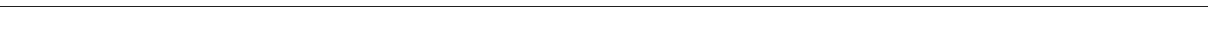
Fig. 6 The PHD module of BAZ1A binds free and nucleosomal DNA. a Sequence alignment of the PHD modules of BAZ1A, BAZ1B, and the most N-terminal PHD module of dAcf1 amino acid boundaries are indicated, and identical residues are highlighted in gray . Filled and open circles indicate the Zn-binding Cys 4 HisCys 3 motif characteristic of the PHD fold. Green arrowheads indicate K1181 and K1183 that are required for BAZ1A-PHD to bind DNA. b Electrostatic surface representation of BAZ1A-PHD (model) and BAZ1B-PHD (PDB: 1F62). Red and blue indicate negatively and positively charged areas, respectively. The positively charged surface formed by K1181 and K1183 in the BAZ1A-PHD model and the corresponding region in BAZ1B-PHD are outlined in dotted green . c Steady-state biolayer interferometry measurement of DNA binding to wild-type BAZ1A-PHD, BAZ1B-PHD, or mutant versions of BAZ1A-PHD bearing the single K1181A or the double K1181A/K1183Y substitutions. d Average relative deuterium uptake difference (ARDD) for BAZ1A-PHD bound to DNA compared to uncomplexed BAZ1A-PHD, measured by HDX-MS. The values for six matching peptides (recovered from both DNA-bound and uncomplexed samples) are represented by histograms spanning the corresponding amino acid sequence of the BAZ1A-PHD construct. No matching peptides were obtained for residues 32 – 42 and histograms of overlapping peptides are shown in transparency. Residue numbering refers to the tag-free expression construct used for this experiment; residues colored in red do not belong to the endogenous BAZ1A sequence. The two lysine residues colored in blue and highlighted with blue arrowheads correspond to K1181 and K1183. Peptide sequences with the highest ARDD values ( > 10%) are highlighted in green ; see Supplementary Fig. 7a, and the “ Methods ” section for more details. e Peptides with the highest ARDD values ( > 10%) were mapped on the BAZ1A-PHD model surface and shown in green . K1181 and K1183 (residues 47 and 49 in d ) are colored in blue , and white areas correspond to residues 32 – 42, for which no ARDD data was obtained. f Same as c but using mononucleosomes. Each data point is the mean value ± s.e.m from four independent experiments. Fitted K D s were determined from the averaged data and reported ± standard